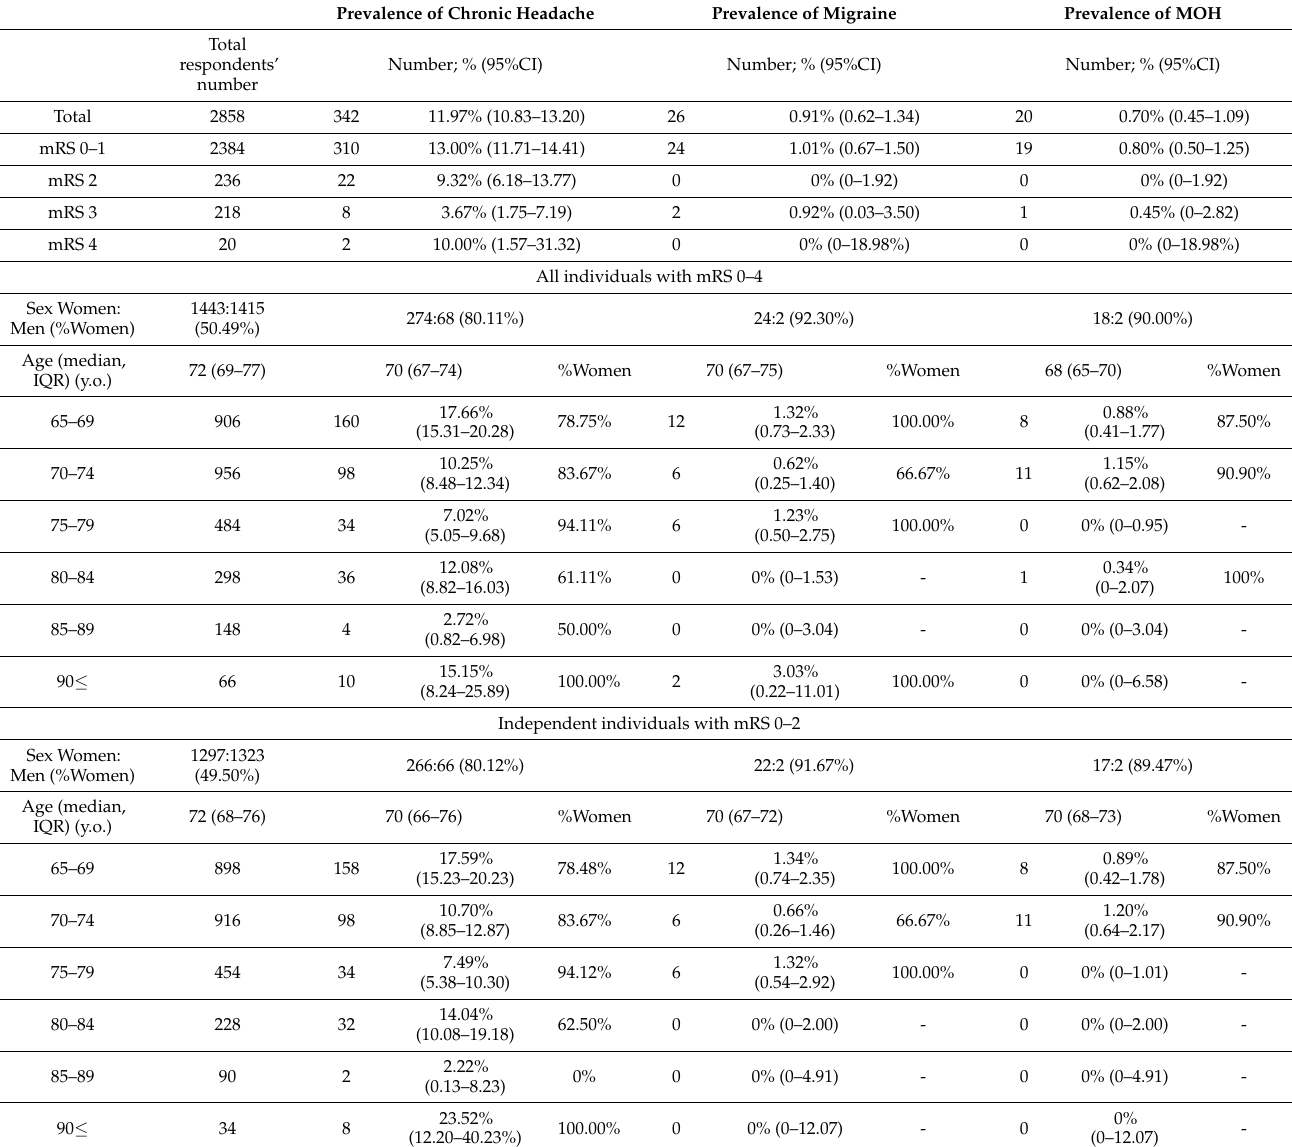
Table 2. Prevalence of headache